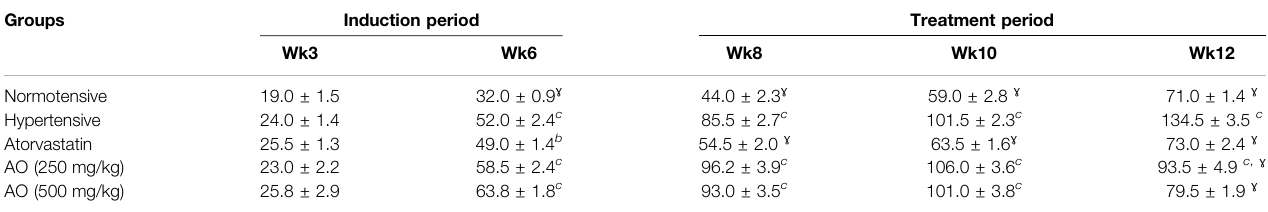
TABLE 1 | Effect of chronic administration of Alpinia of fi cinarum on weight gain (g) in obesogenic diet-fed hypertensive rats. Groups